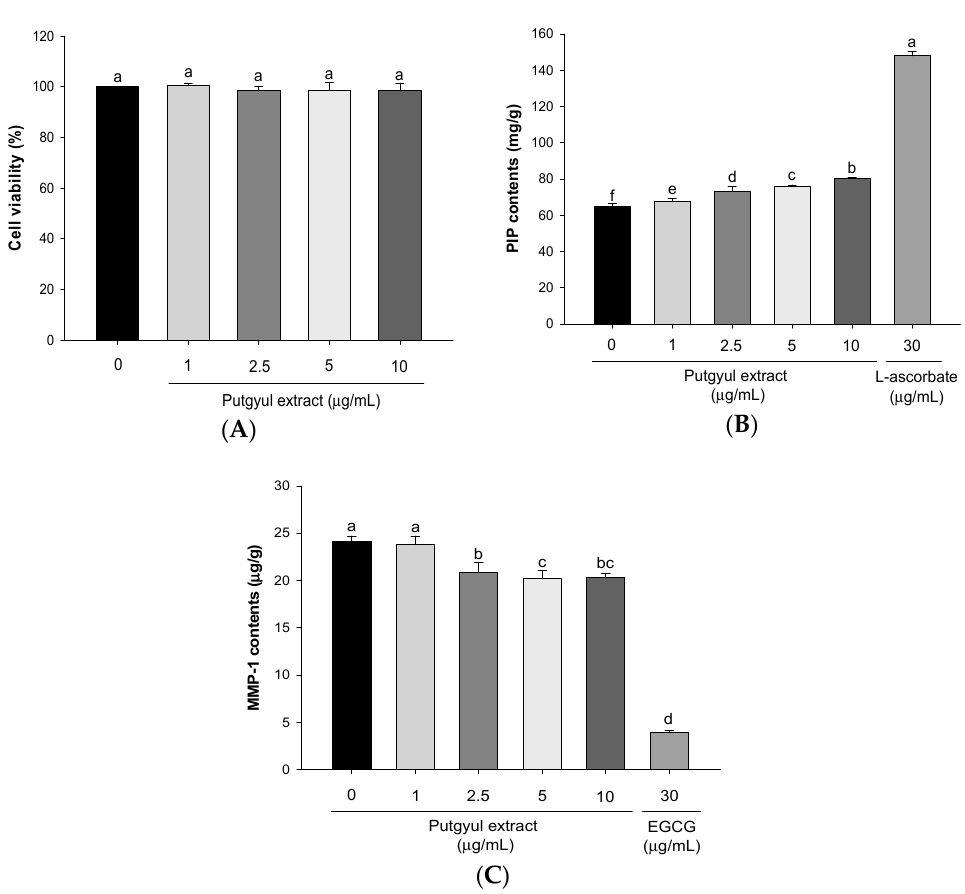
Figure 1. Effects of putgyul extracts on collagen contents and matrix metalloproteinase (MMP)-1 in human dermal fibroblasts (HDFs). ( A ) Cell viability of putgyul extracts in HDF; ( B ) PIP contents in HDF after treatment with putgyul extracts; ( C ) MMP-1 contents in HDF after treatment of unripe citrus extracts. a–f All values are presented as mean ± standard deviation. Bars with different letters indicate statistically significant differences among the groups at p < 0.05 by one-way ANOVA. EGCG, epigallocatechin gallate